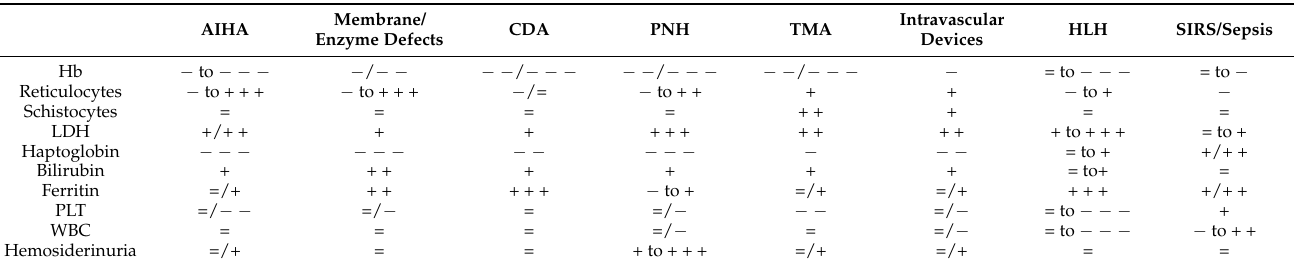
Table 5. Markers of hemolysis in different settings including HLH and